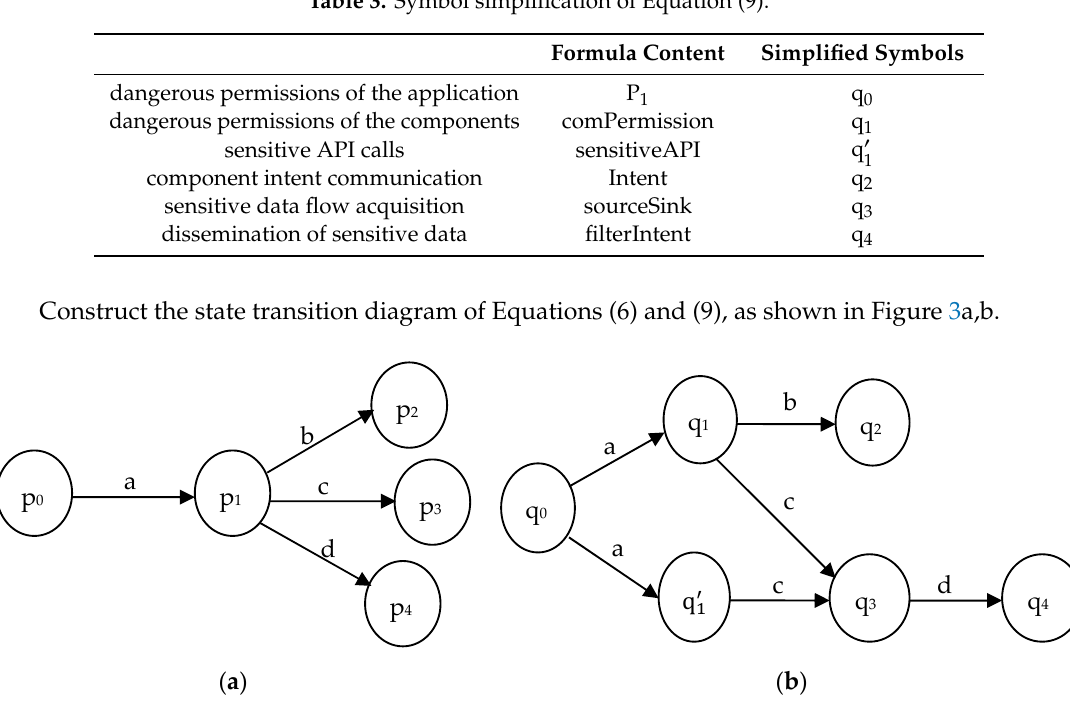
Table 2. Symbol simplification of Equation (6). Formula Content Simplified Symbols dangerous permissions of the components